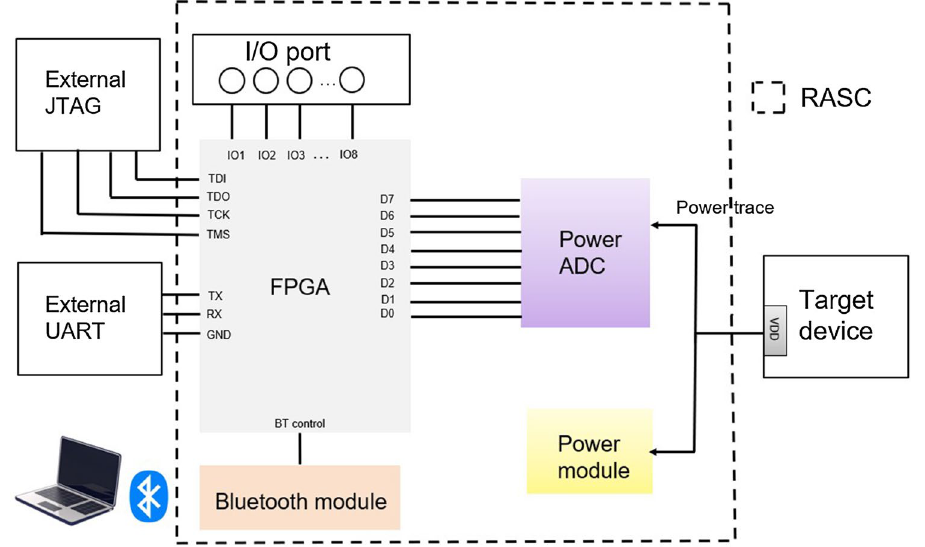
Fig. 2 RASC schematic. The power module on RASC is powered by the Vdd pin on the target device. The input power traces are digitalized by the power ADC circuit on the board. The external JTAG is connected to program the RASC’s FGPA. External UART module is used to transmit power traces in the train- ing phase. In the testing phase, RASC uses a Bluetooth module to transmit pass/ fail/suspect outcomes from instruction-level classifiers. Except for these modules, there are 8 I/O ports left on RASC for achieving other potential